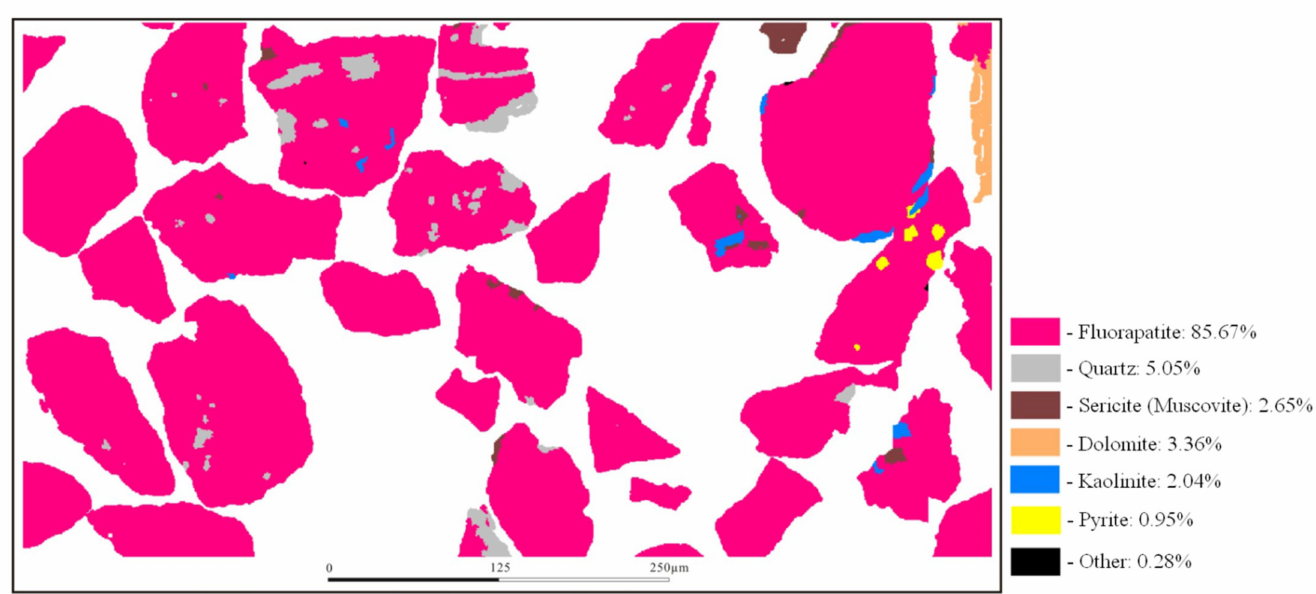
Figure 5. Apatite wrapped with fine-grained quartz, sericite (muscovite), kaolinite, pyrite, and dolomite.